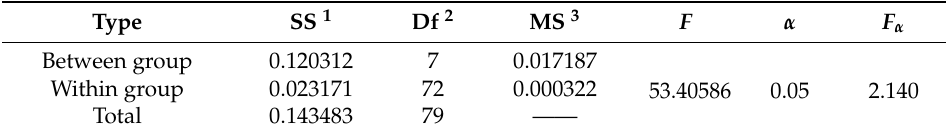
Table 4. The results of ANOVA of the image 1.